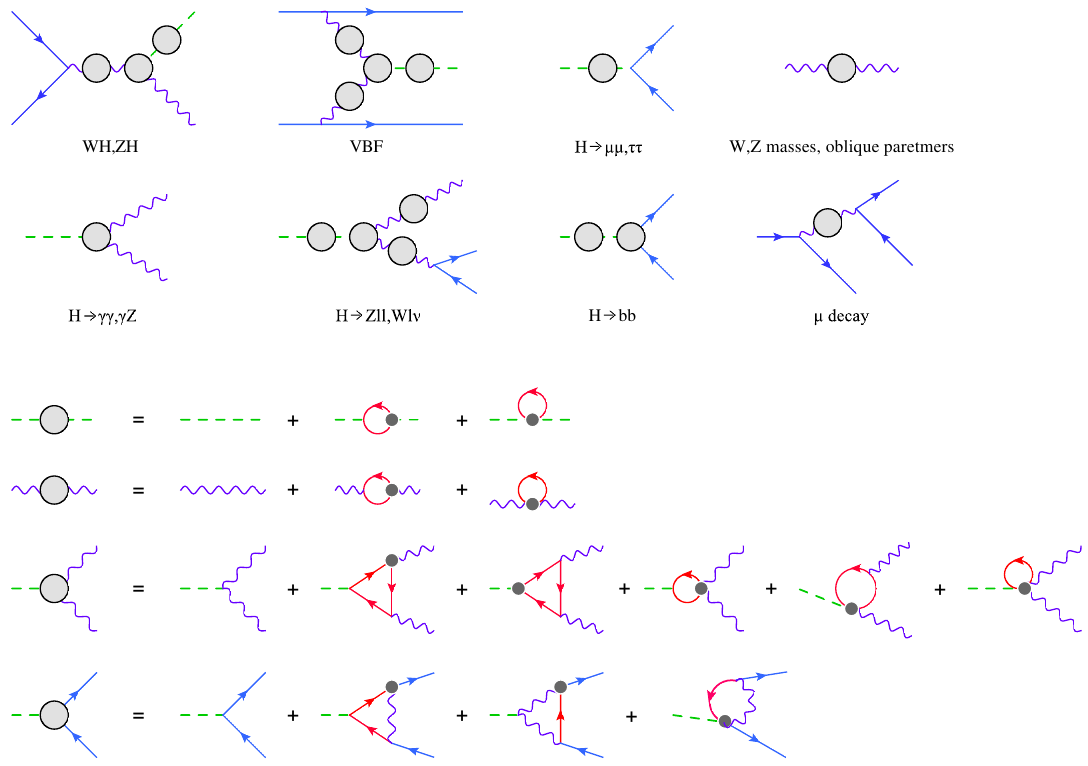
Figure 1 . Electroweak contributions from two-fermion top-quark operators to the production and decay of the Higgs boson, the oblique parameters, and the SM input parameters which we will take as M W , M Z and G F (from muon decay). Here blue fermion lines represent light fermions, and red fermion lines represent the top quark. Large grey blobs denote collectively the SM contributions and dim-6 EW corrections from top-quark loops, as illustrated below the processes. Dark small blobs represent the dim-6 operator insertions. Diagrams that can be obtained by crossing legs or reversing fermion (cid:13)ows are not